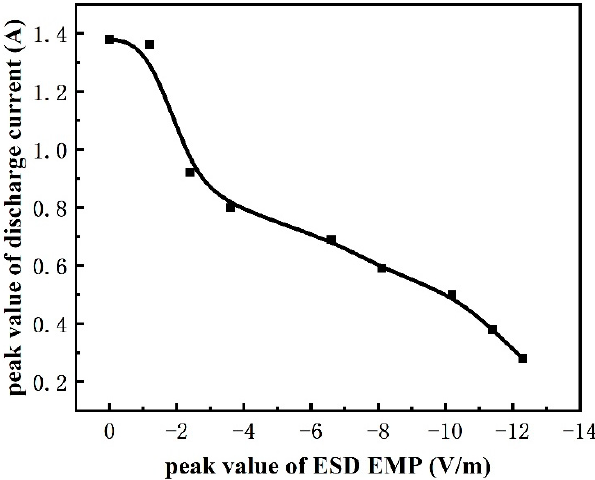
Figure 9. Variation trend of discharge peak value of solar array with different peak value of ESD EMP radiation.